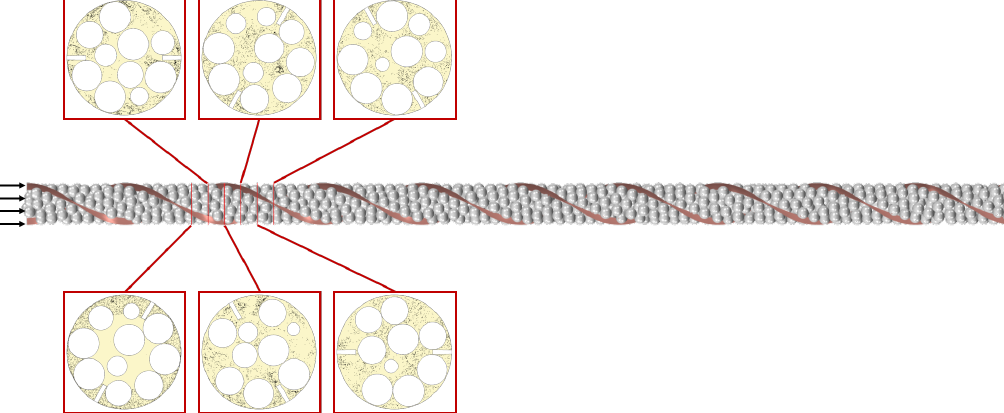
Figure 11. Helical design: Visualization of the intersection points of streamlines with cross-sectional planes at a distance of 10mm The streamlines were injected in the annular space near the wall at a bed height of